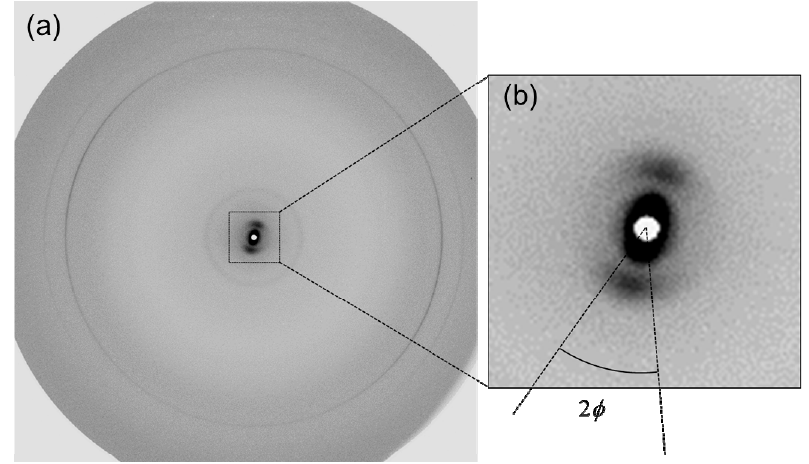
Figure 2. An X-ray diffraction pattern of an isolated human stratum corneum (SC) sheet obtained using the sample holder described in ( a ) and the enlarged image of the small angle region ( b ). Angular spread of the reflection corresponds to the extent of the orientation of the intercellular lipid layers (see text).